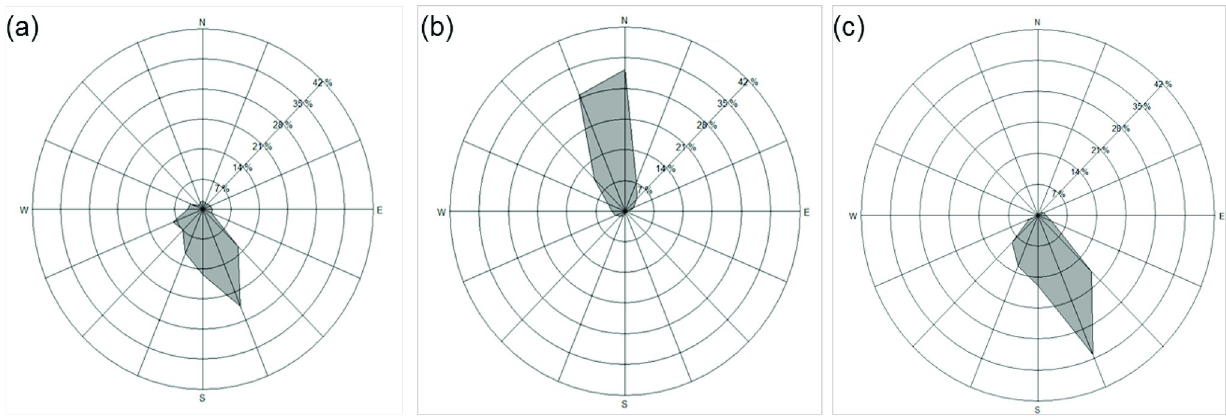
Fig 3. Wind roses of wind direction frequencies measured hourly between 6:00 a.m. and 4:00 p.m.. (a) June 17 to July 1, 2009; (b) November 4–18, 2009; and (c) June 14–28, 2010. The scales measure the hourly occurrence gusts from different directions.